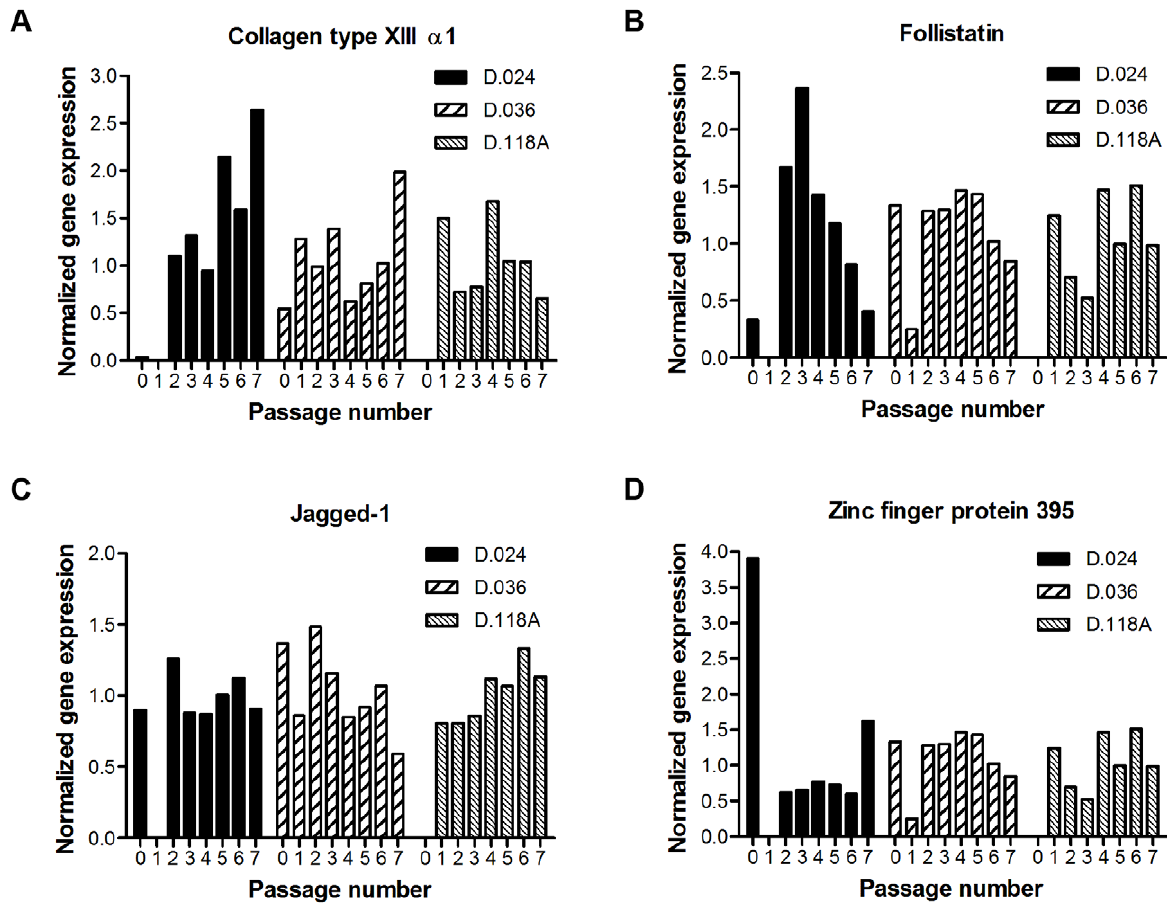
Figure 4. Gene-expression correlated to invitro aging. The trend observed in relation to in vivo aging could not be confirmed in hMSCs aged in vitro . Gene-expression was determined up to passage 7 in three donors (D.024: female, 59 years, acetabulum; D.036: female, 38 years, iliac crest; D.118A: male, 60 years, acetabulum), however a general trend could not be observed. For some genes the expression pattern was random, A) COL13A1 and D) ZNF395 , and for other genes there seemed to be a trend in one of the donors, but this could not be confirmed in the other two, B) FST and C) JAG1 .